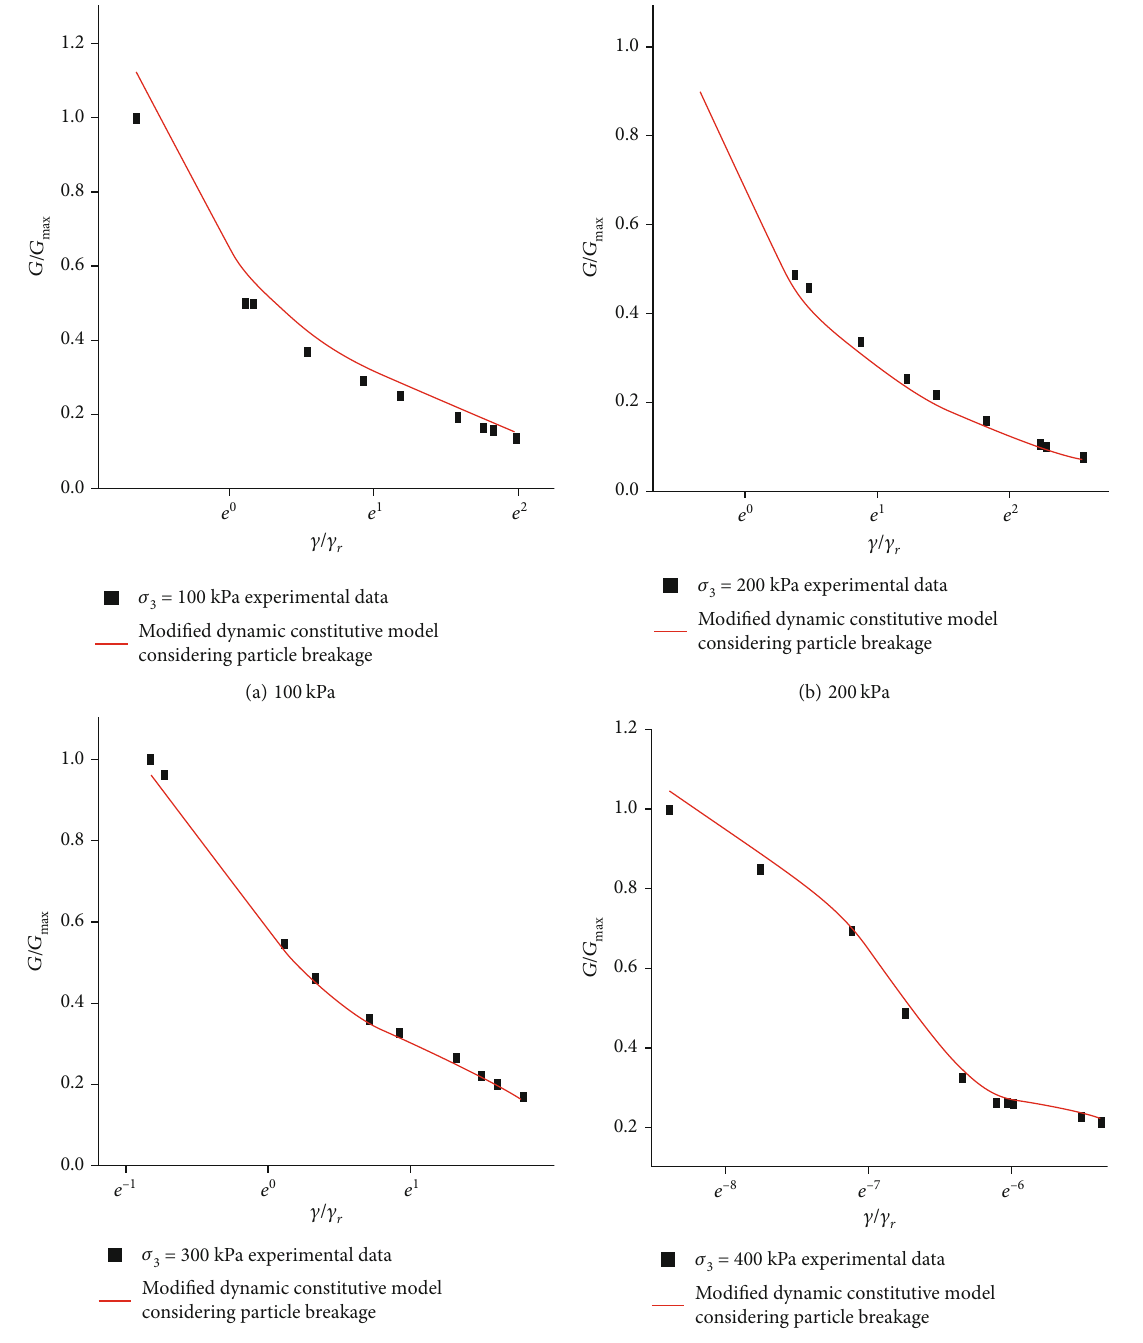
Figure 12: Comparison diagram of G / G